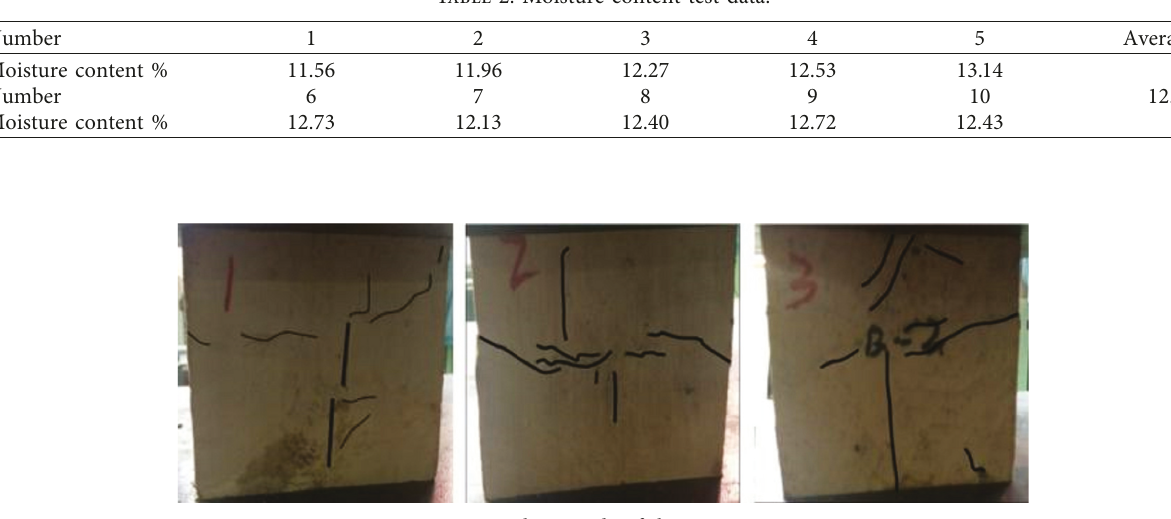
Table 2: Moisture content test data.